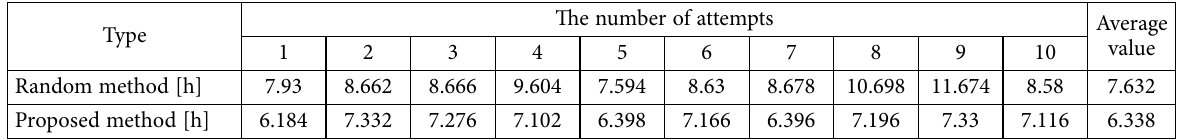
Table 2. The duration of minimal assignment-route